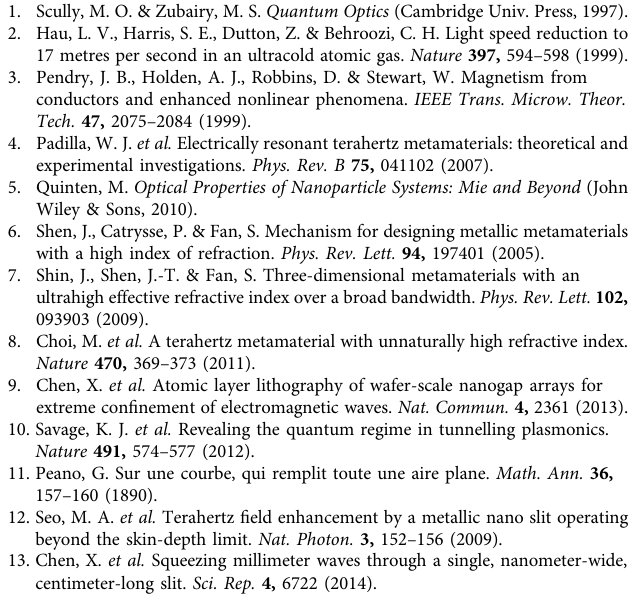
function with full-width-at-half-maximum of 0.1GHz. The moving averaged S 21 data were used to retrieve effective optical parameters. The S 21 raw data are in the Supplementary Fig. 12.